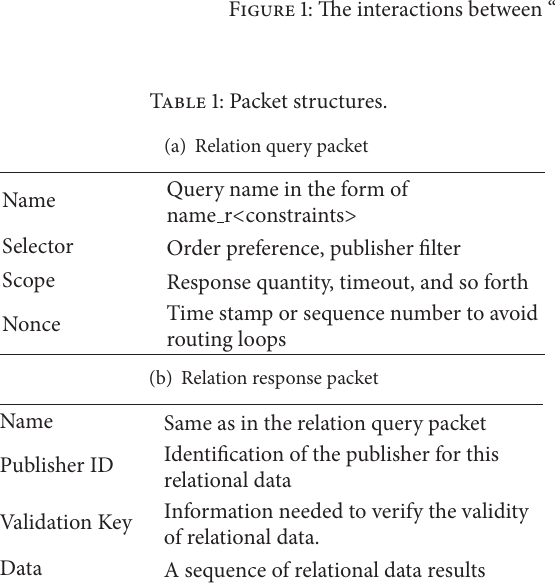
Figure 1: The interactions between “semantic guider” and other network entities.